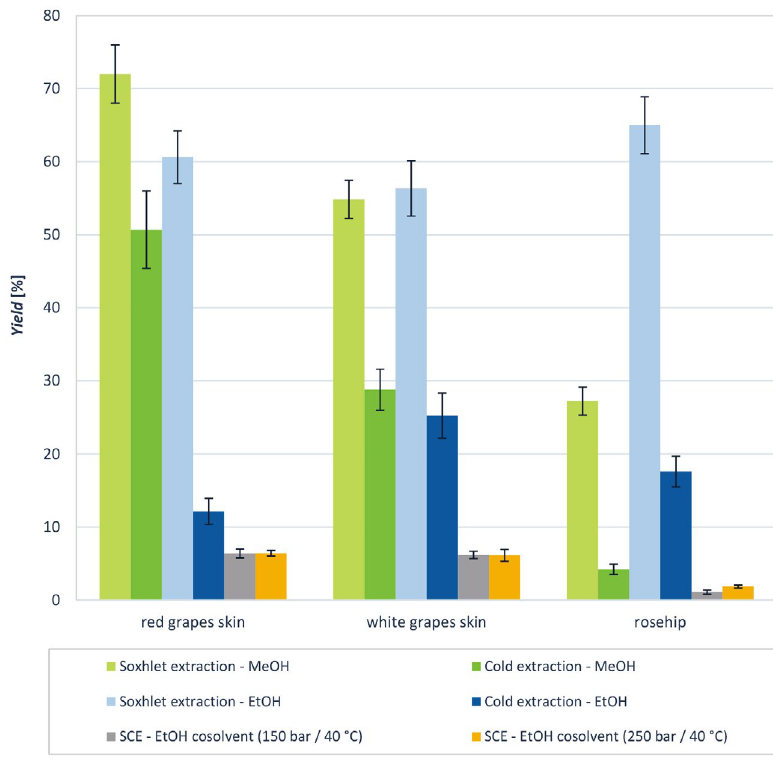
Figure 1: Comparison of extraction yield of red, white grapes skin and rosehip using different extraction